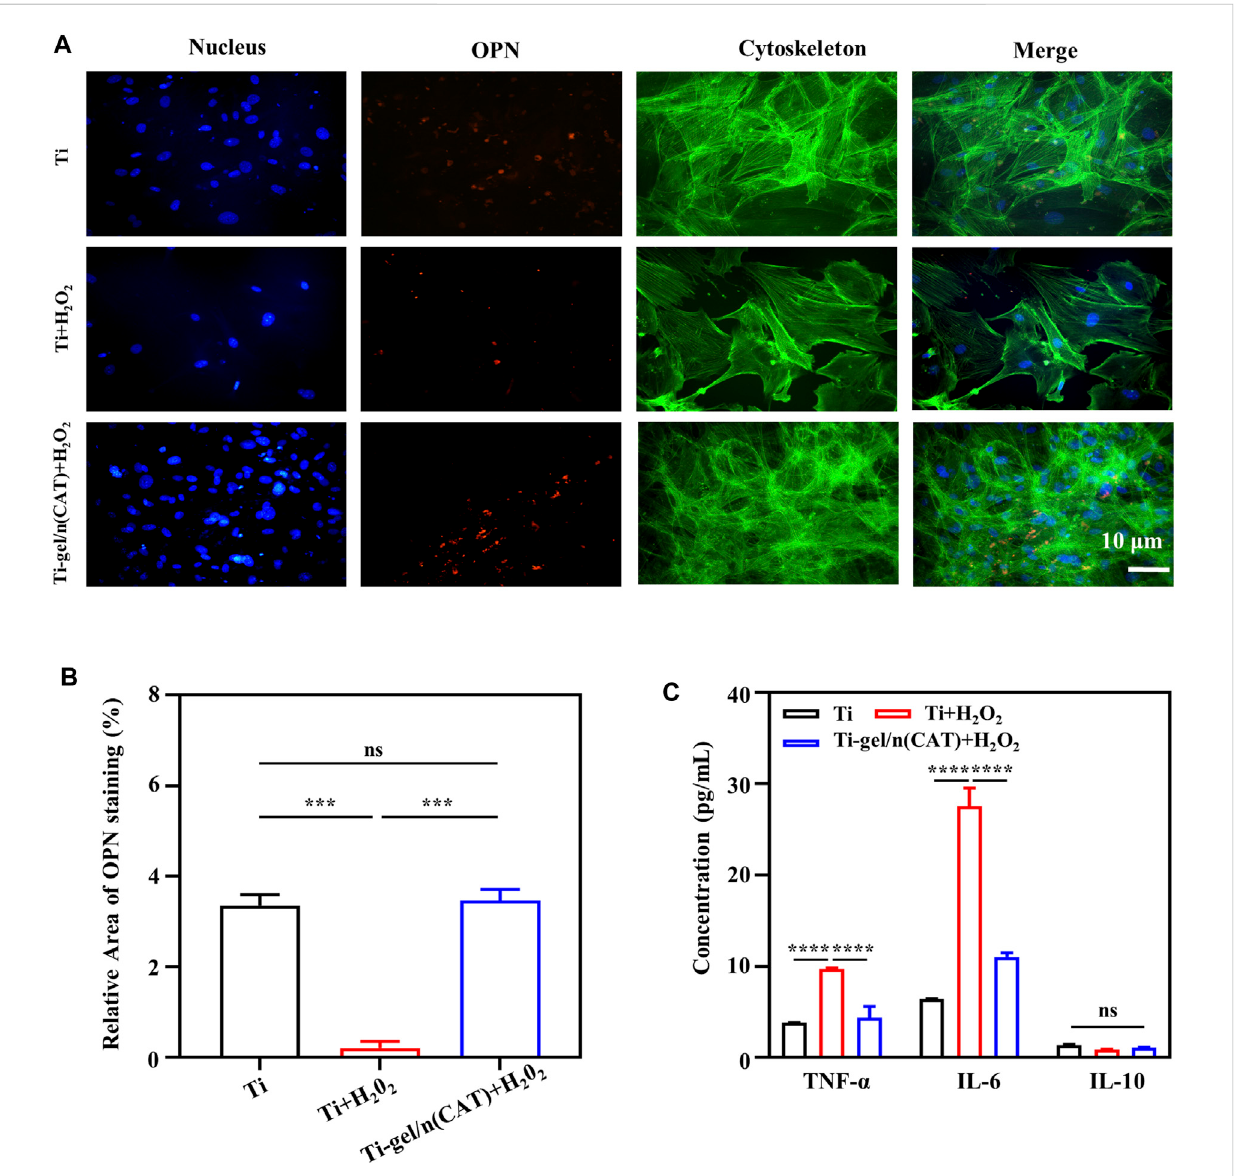
FIGURE 5 OPN expression by osteoblasts on the surface of different materials in a persistent chronic in fl ammatory environment. (A,B) Immuno fl uorescence images of OPN staining on different surfaces of the material. The OPN was stained in red, and the quantitative analysis of the OPN immuno fl uorescence imageswasanalyzedusingImageJsoftware. (C) Cytokineexpressionlevelsofmacrophagesondifferentmaterialsurfaces.(n=3,nsmeansthatthereare no signi fi cant differences, *** p < 0.001, **** p <